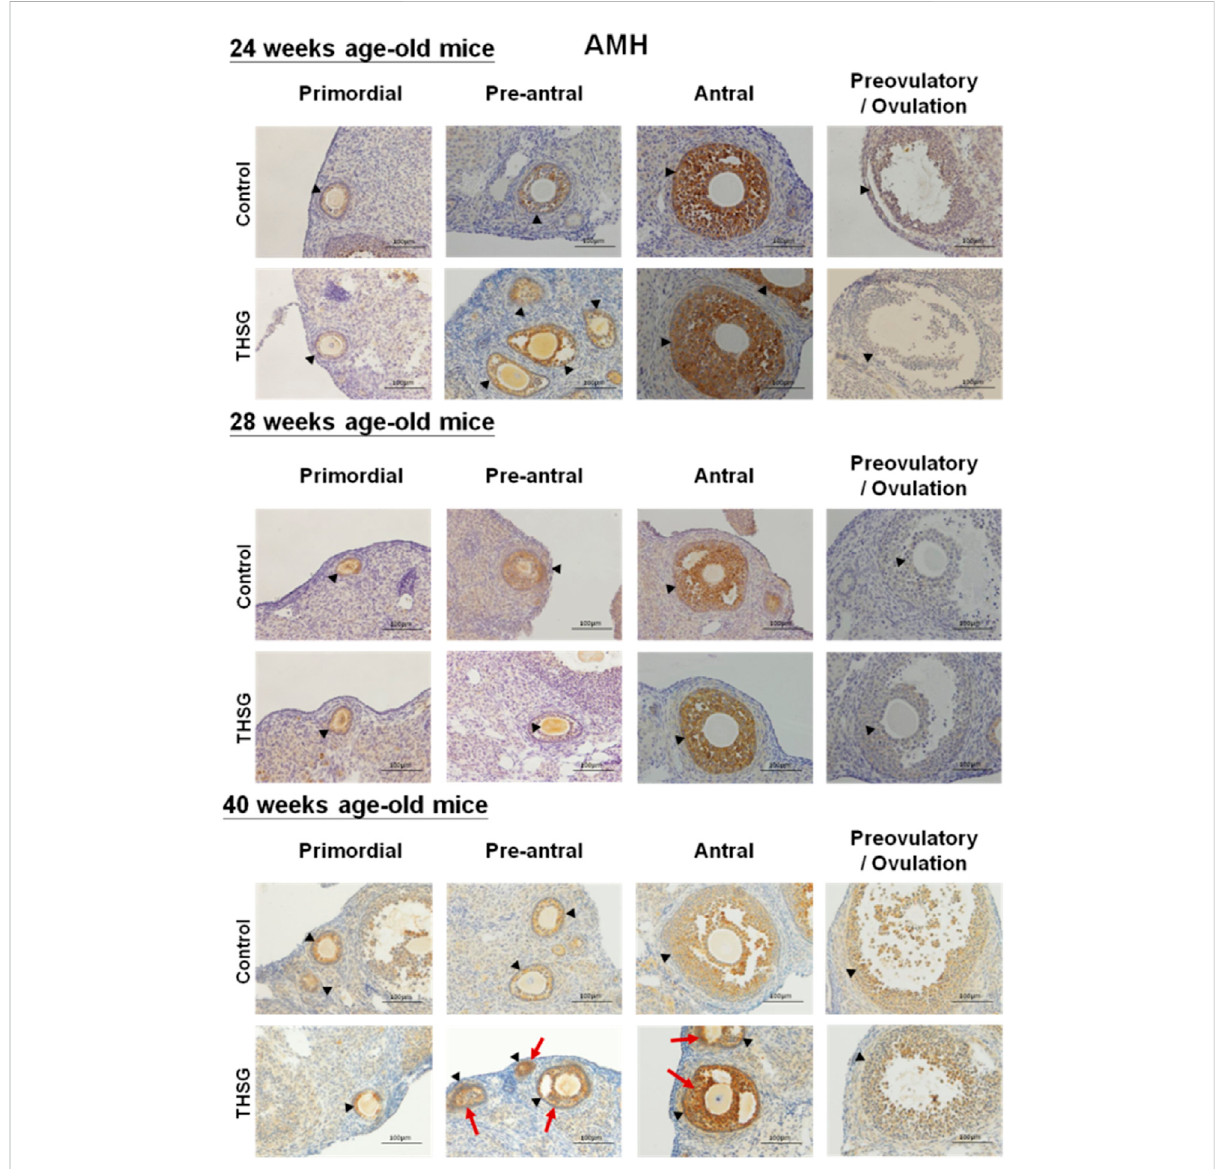
FIGURE 6 THSG affects protein levels of AMH in different stages of folliculogenesis. The black triangles indicate the follicle formation, and the red arrows indicate the signi fi cant AMH accumulation (the brown area). Mice fed with THSG or untreated controls were sacri fi ced at the end of 24, 28, and 40 weeks of age. IHC of AMH was stained. AMH accumulation showed no difference between the THSG-fed and untreated control groups in 24- week-oldand28-week-oldmice.TherewasmoredominantAMHaccumulation,especiallyduringtheantralfollicularphaseinTHSG-fedelder mice groups (40-week-old mice) than in the control